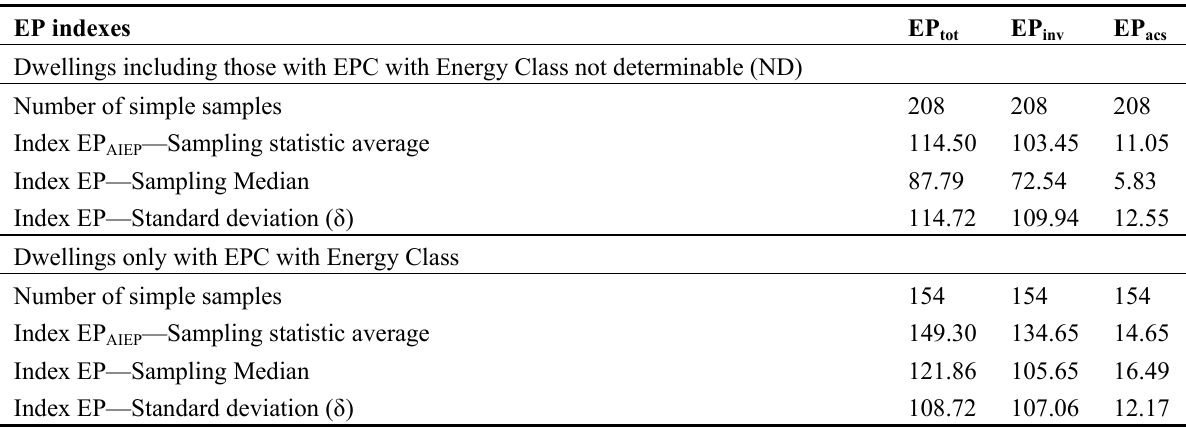
Table 3. Statistical data. SACE database 2010.